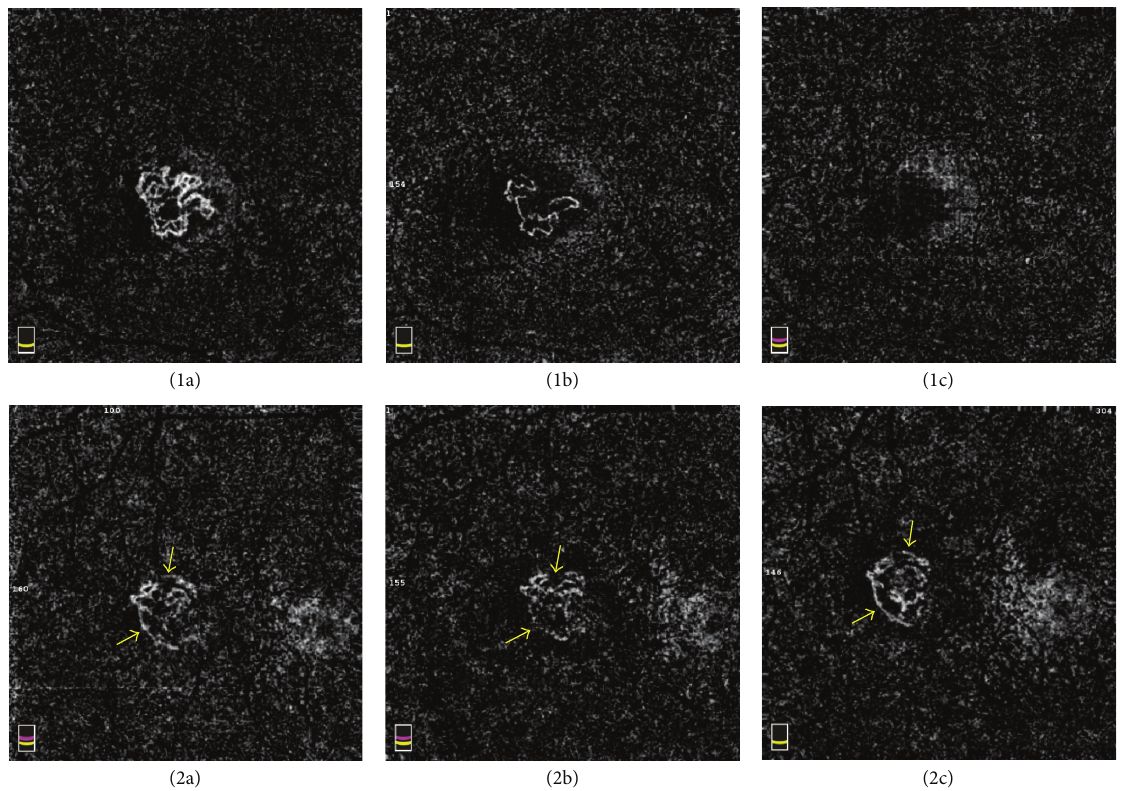
Figure 2: Changes of CNV after intravitreal anti-VEGF treatment of 2 patients 1-2: 3 × 3 OCTA images of each subject. ((a)–(c)) CNVs form before treatment, 1 day after treatment, and 1 month after treatment on OCTA. ((1a)-(1b)) Visible shrinkage of lesion from peripheral vessels and reduction in number and density of vessels at 1 day after treatment. (1c) After 1 month, no detected CNV flow. ((2a)–(2c)) The CNV changes of one female patient whose small abnormal vessels reappeared in previous lesion 1 month after treatment comparing to 1 day (yellow arrows).